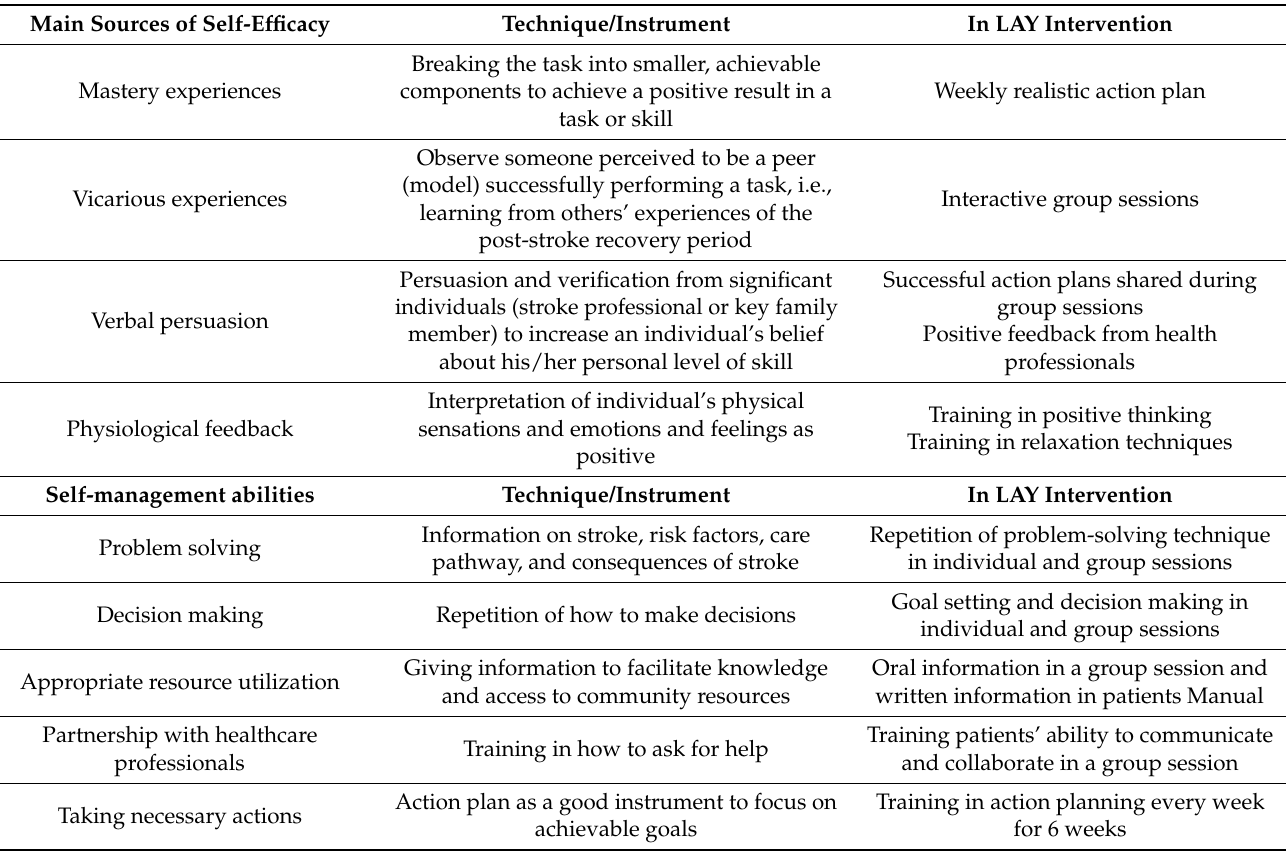
Table note: LAY—Look After